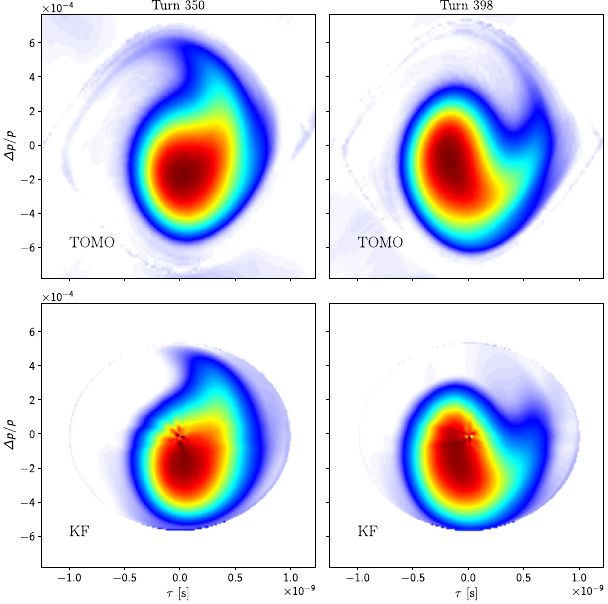
FIG. 4. Comparison between the results of the standard tomography phase-space reconstruction (TOMO) and the Kalman filter-based reconstruction (KF) in the presence of injection oscillations.